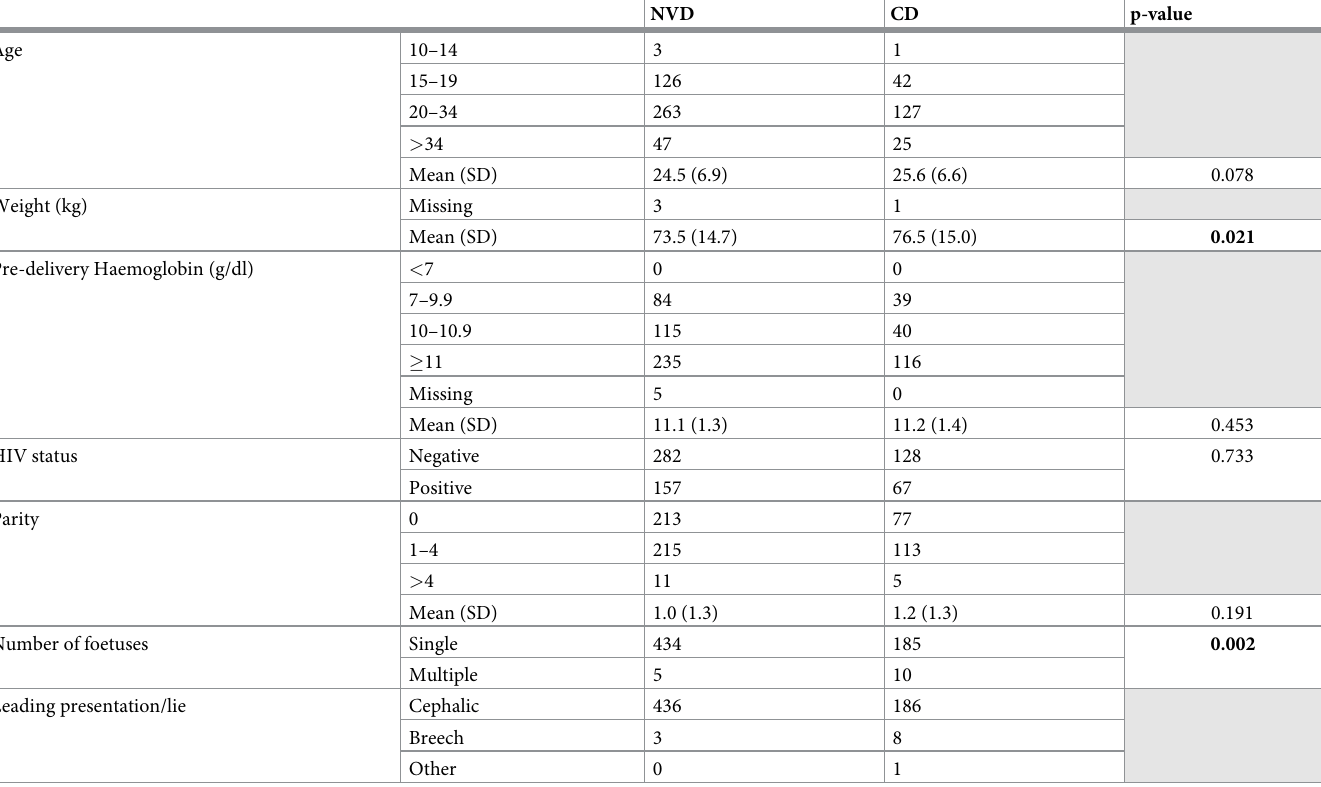
Table 1. Clinical characteristics of